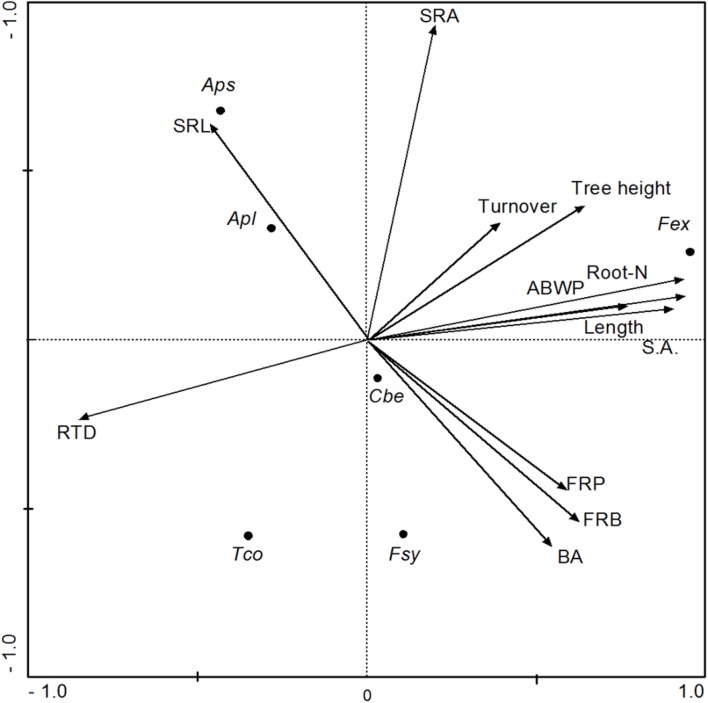
Results of a Principal Components Analysis regarding the parameters fine root biomass (FRB), root morphological properties (RTD, SRA, SRL), annual production of fine root biomass (FRP), length (Length) and surface area (SA), root turnover, and tree basal area (BA) and aboveground woody biomass production (ABWP). Shown are the inter-relationships along the first two axes (axis 1 = x axis; axis 2 = y axis). Species: Fex, Fraxinus excelsior; Aps, Acer pseudoplatanus; Apl, Acer platanoides; Cbe, Carpinus betulus; Tco, Tilia cordata; Fsy, Fagus sylvatica.